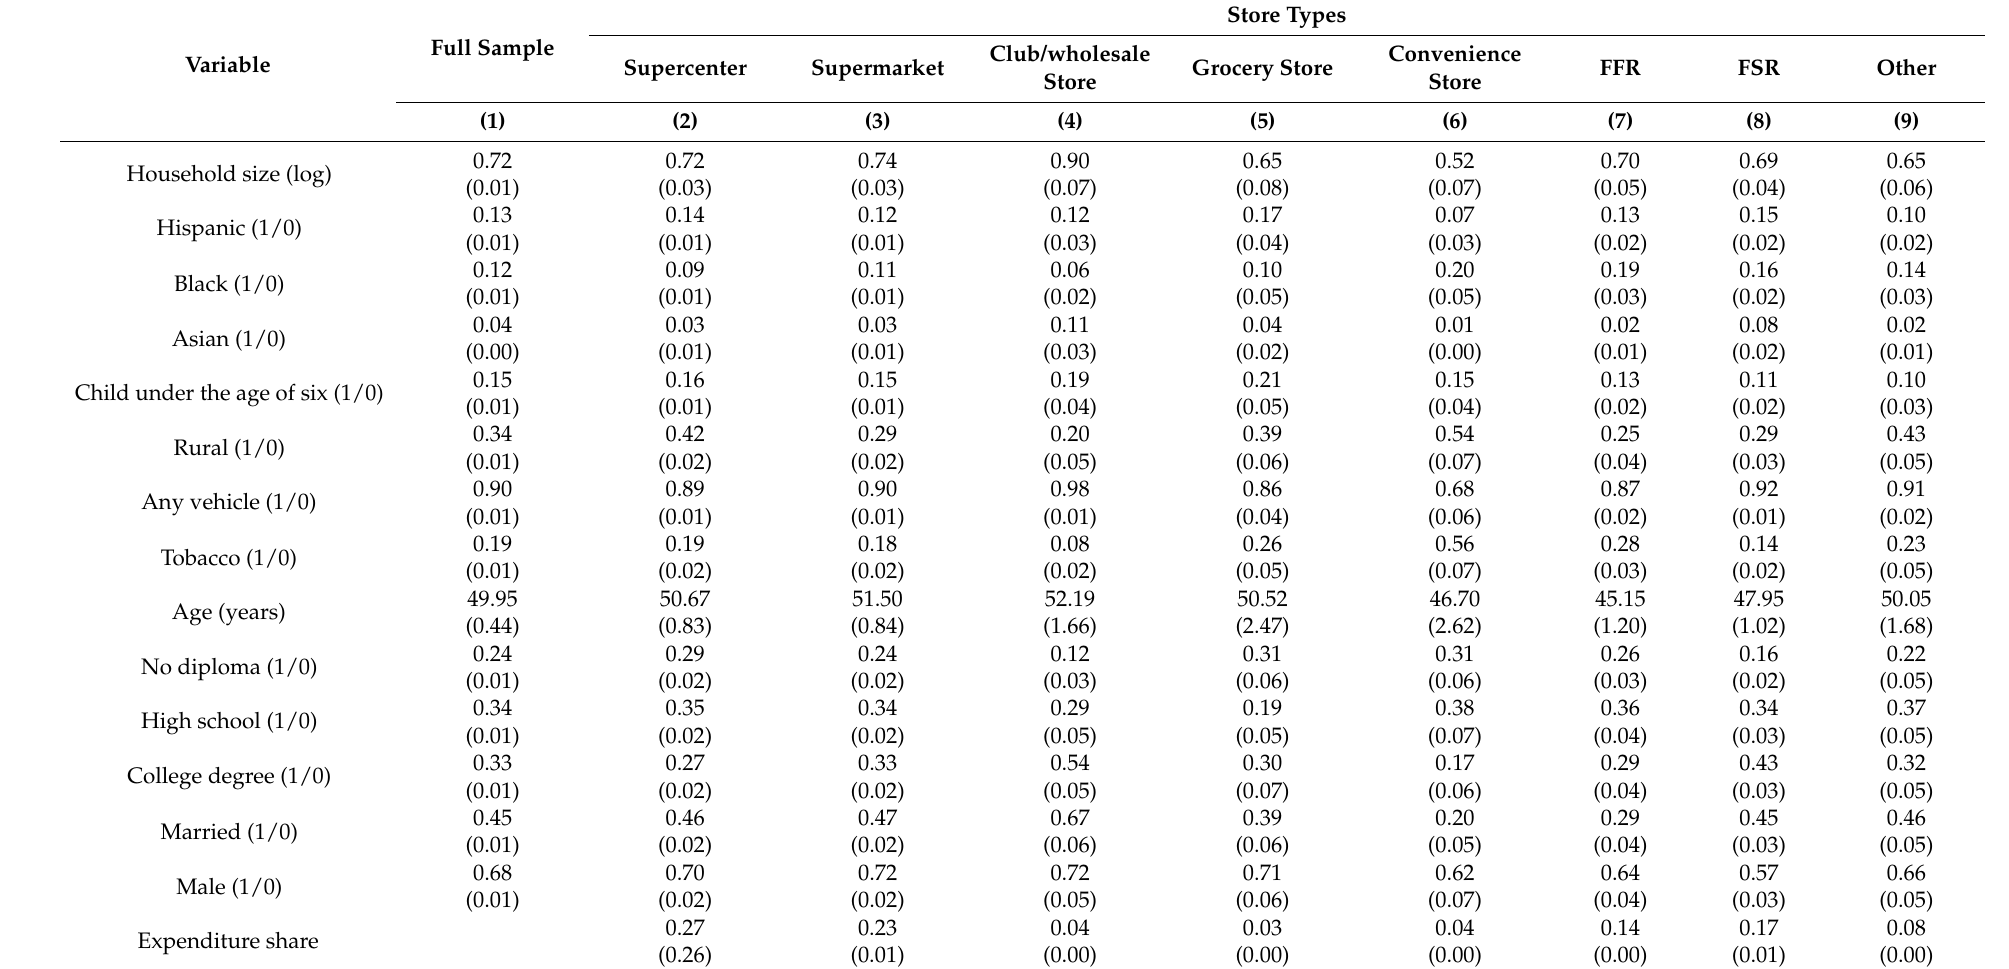
Table 2. Summary statistics of covariates by store types in the